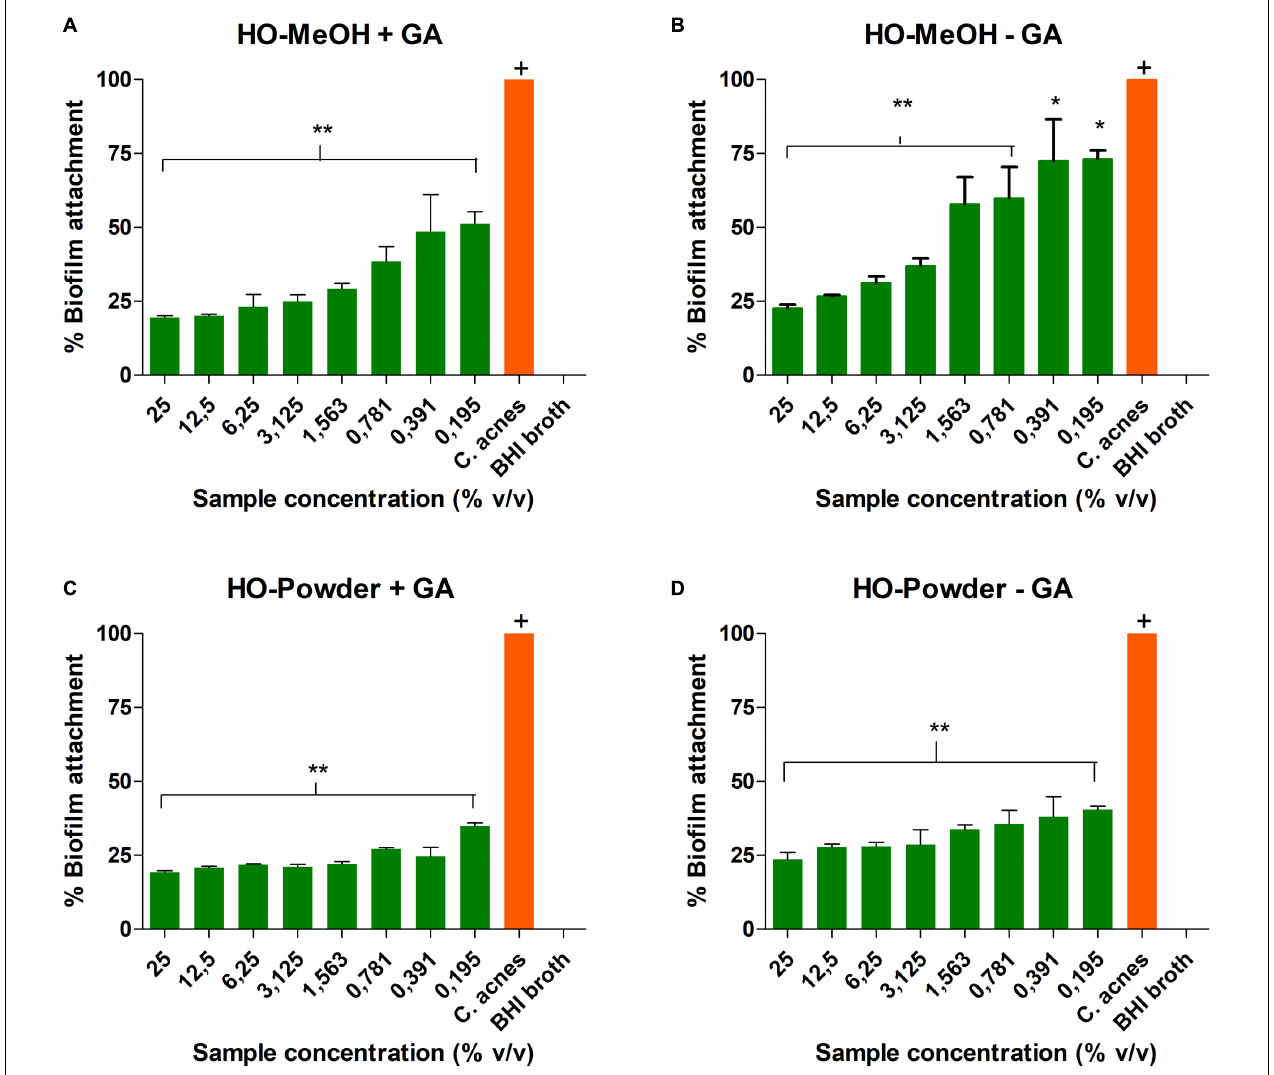
FIGURE 10 | The percentage adhesion of Cutibacterium acnes treated for 72 h with (A) Helichrysum odoratissimum methanol extract AuNPs + Gum arabic, (B) H. odoratissimum methanol extract AuNPs – Gum arabic, (C) H. odoratissimum leaf powder AuNPs + Gum arabic, (D) H. odoratissimum leaf powder AuNPs – Gum arabic compared to the untreated C. acnes control. * Represents significance where p < 0.05, ** represents significance where p < 0.01, + represents the control to which all other samples were compared.